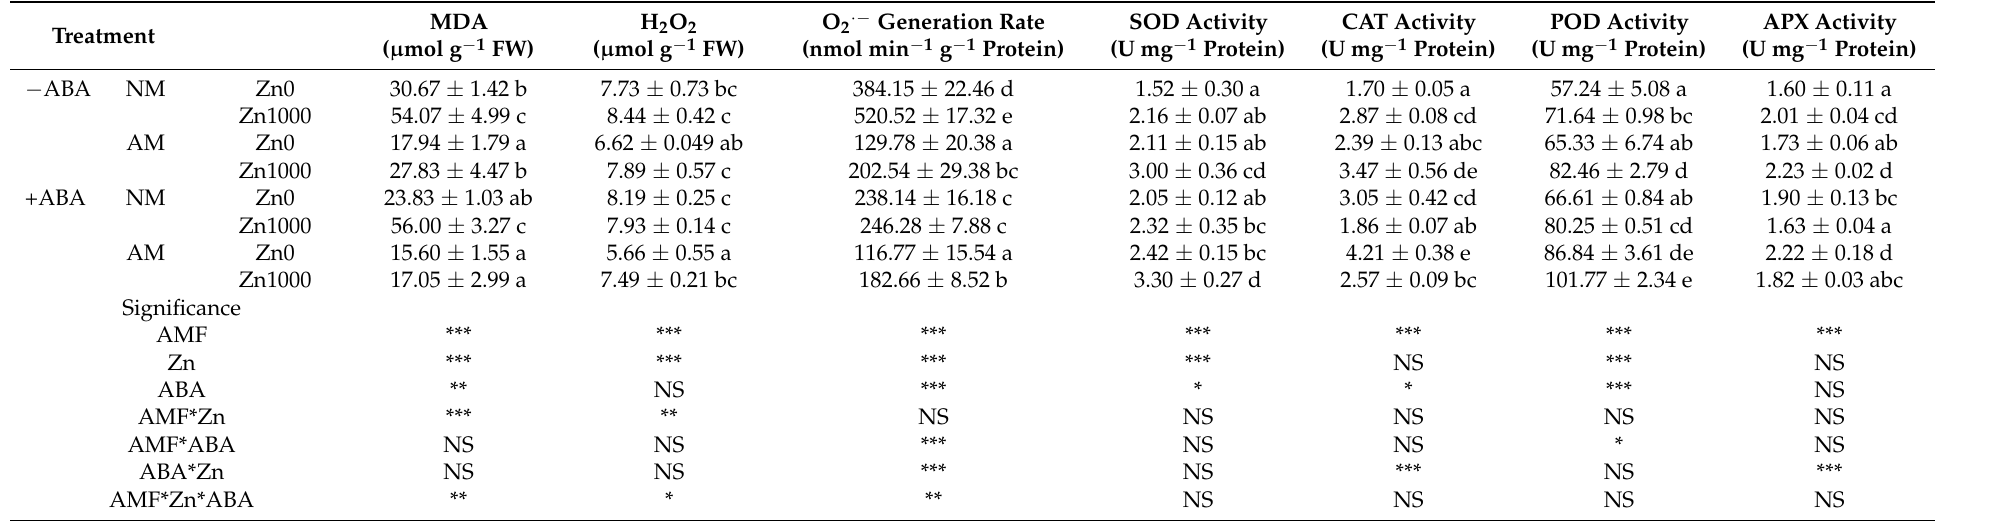
Table 2. Contents of MDA and H 2 O 2 , O 2 ·− generation rate, and the activity of antioxidant